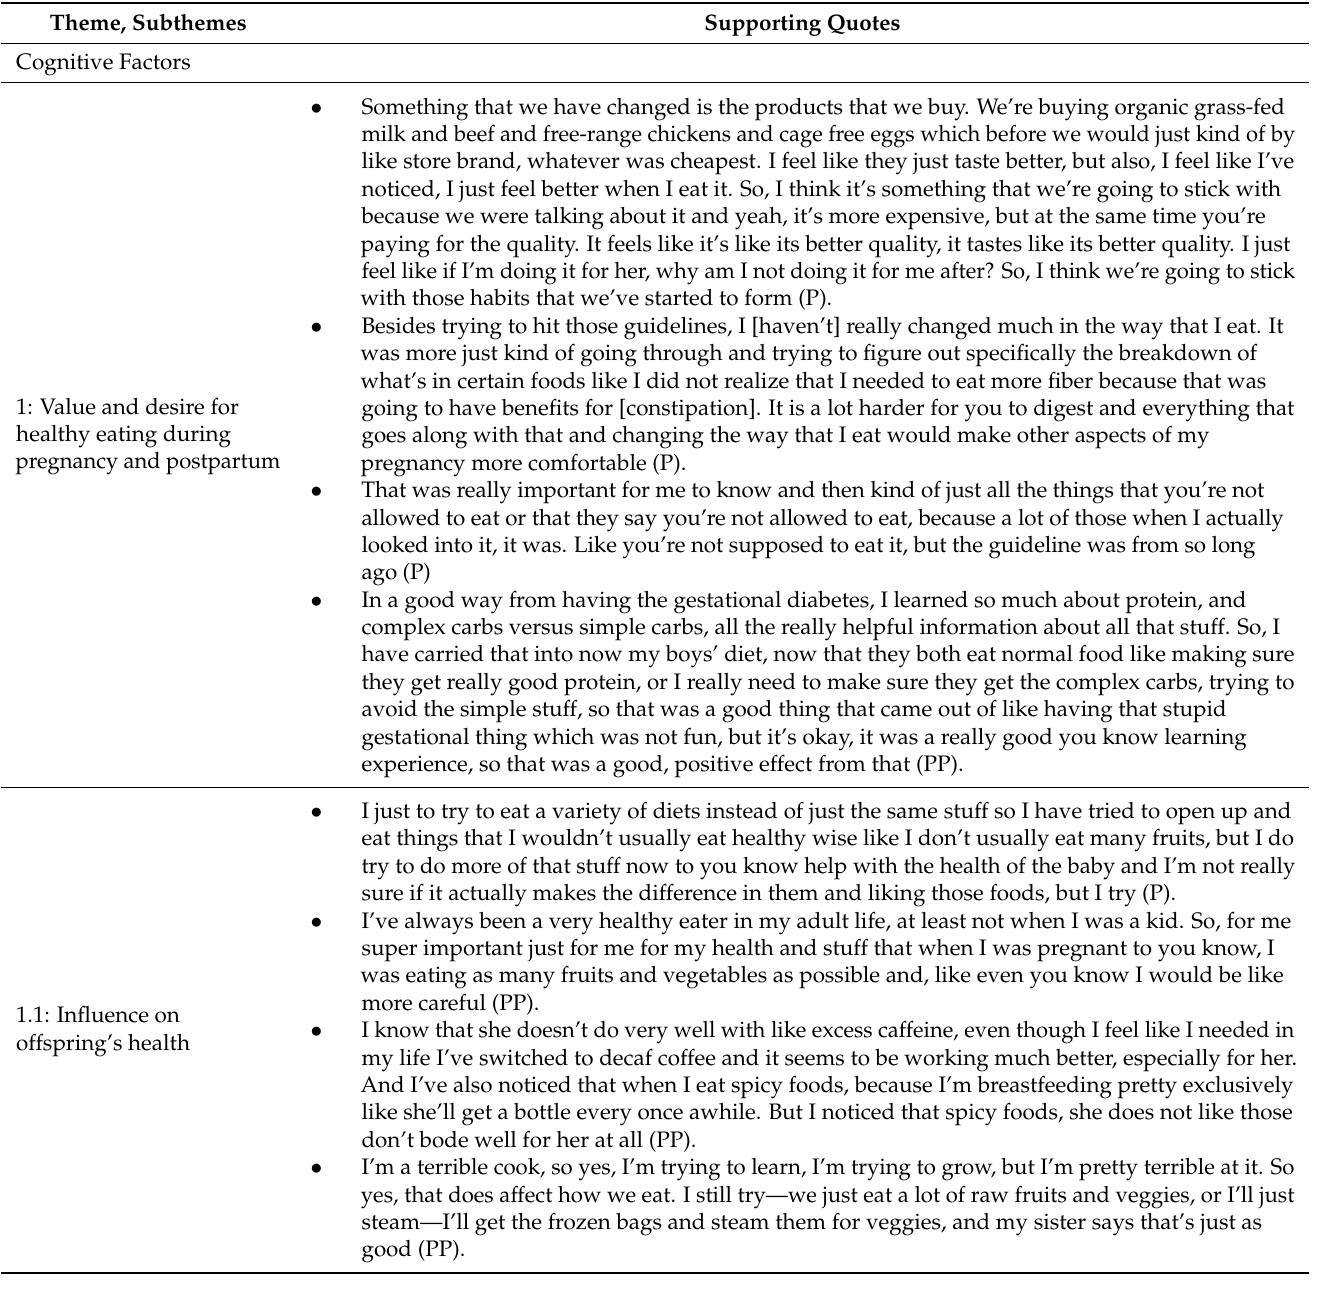
Table 3. Emergent themes for pregnant and postpartum women by SCT